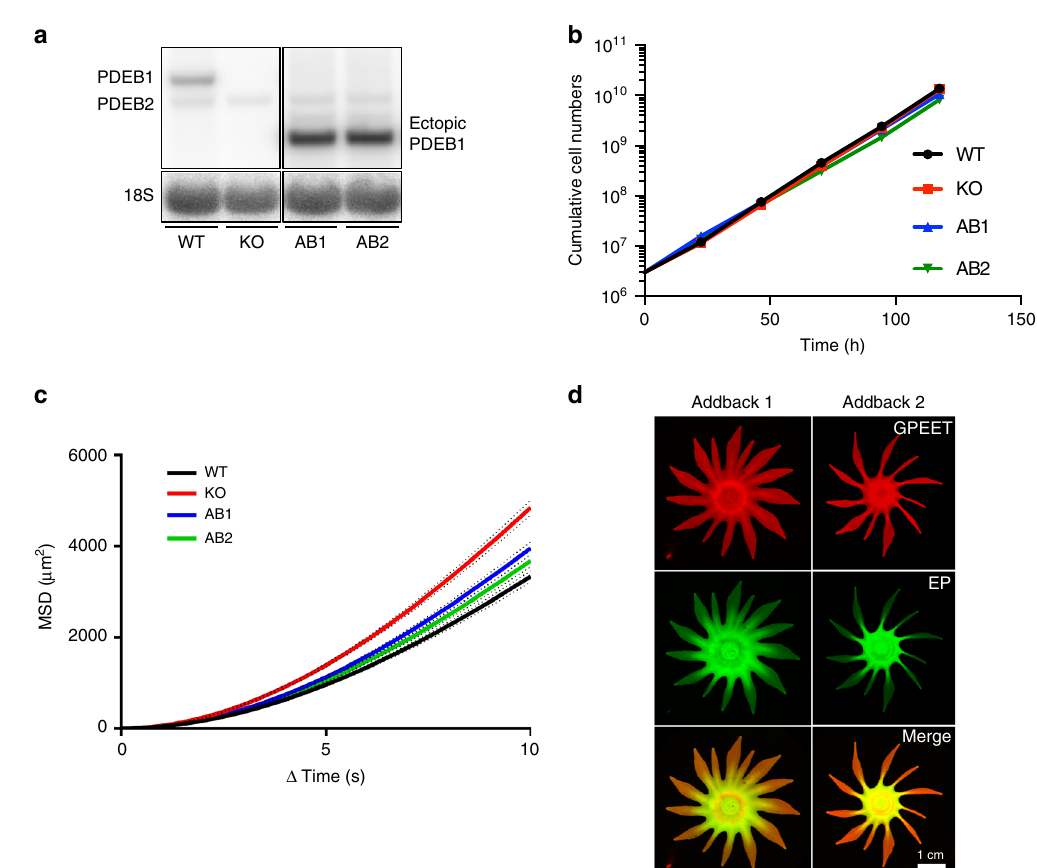
Fig. 4 Ectopic expression of PDEB1 in the PDEB1 KO restores SoMo. a Northern blot analysis of RNA from WT, PDEB1 KO and two addback clones, AB1 and AB2, expressing an ectopic copy of PDEB1 that is integrated upstream of a procyclin locus and transcribed from the procyclin promoter 44 . The addback version has a truncated 3 ′ -untranslated region derived from the EP1 procyclin gene, hence the smaller size of the transcript compared with the endogenous copy. The probe used is described in Fig. 2. 18S rRNA serves as a loading control 66 . The expression of the ectopic copy relative to the endogenous copy is as described in Fig. 2b. c MSD is measured for WT, PDEB1 KO, AB1, and AB2 cells from two biological replicates. Results are from n = 1919 tracks for WT, n = 1824 tracks for PDEB1 KO, n = 1876 tracks for AB1, and n = 1973 tracks for AB2 from a total of 34 videos for each. Dotted lines represent standard error of the mean (SEM). d Community lifts demonstrate addbacks AB1 (left) and AB2 (right) are SoMo-positive and express both GPEET (red) and EP